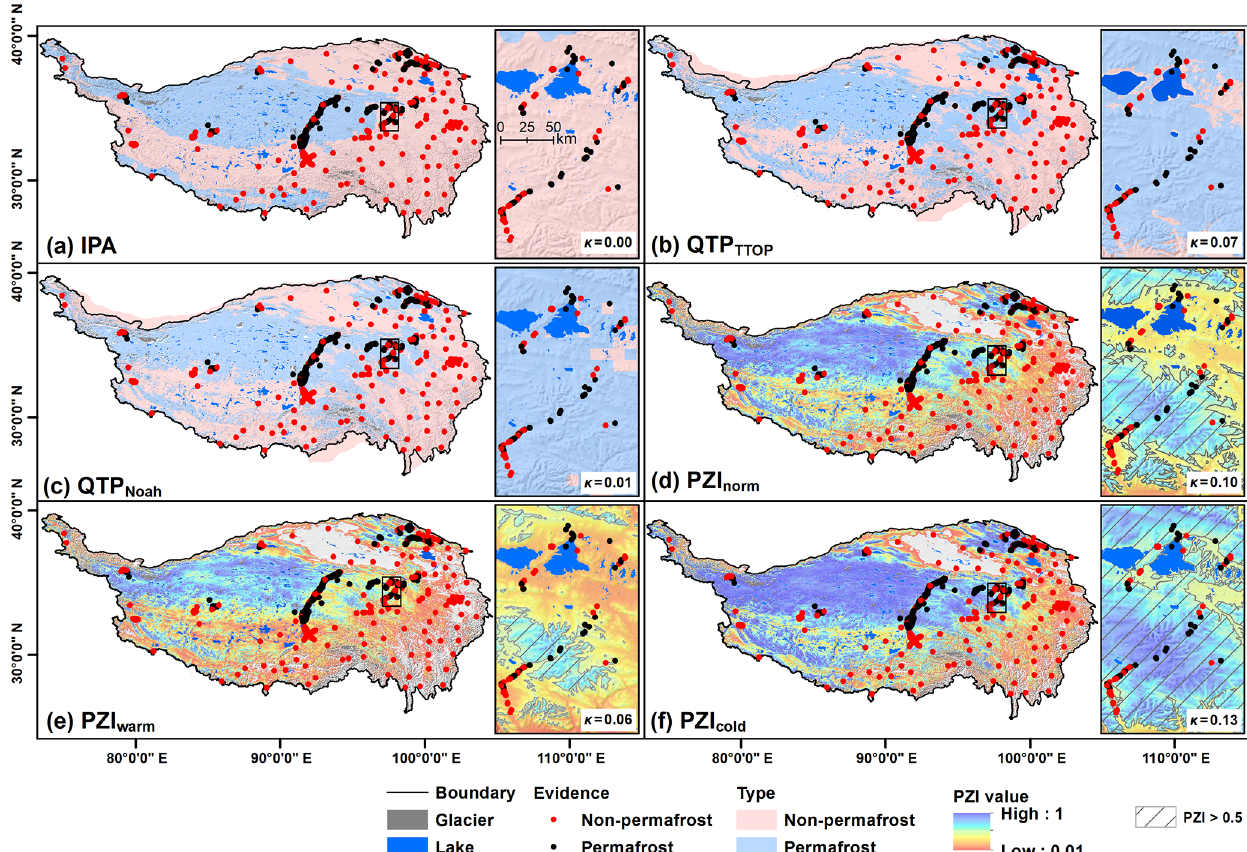
Figure 2. The permafrost classification results at in situ evidence sites shown on the (a) IPA, (b) QTP TTOP , (c) QTP Noah , (d) PZI norm , (e) PZI warm , and (f) PZI cold maps. Cohen’s kappa coefficient ( κ ) was derived from the selected spatially highly variable landscapes (marked by black box) with 106 evidence sites. All the maps are resampled to the unprojected grid of the SRTM30 DEM with a spatial resolution of 30arcsec ( ∼ 1km) to avoid map bias caused by different resolutions, geographic projection, and format. The boundary of QTP used in this study is marked by the black line. Categorical classification is used for the QTP TTOP , QTP Noah , and IPA maps, while the continuous PZI was present for the PZI norm , PZI warm , and PZI cold maps. The blank parts in the PZI maps are areas with PZI <